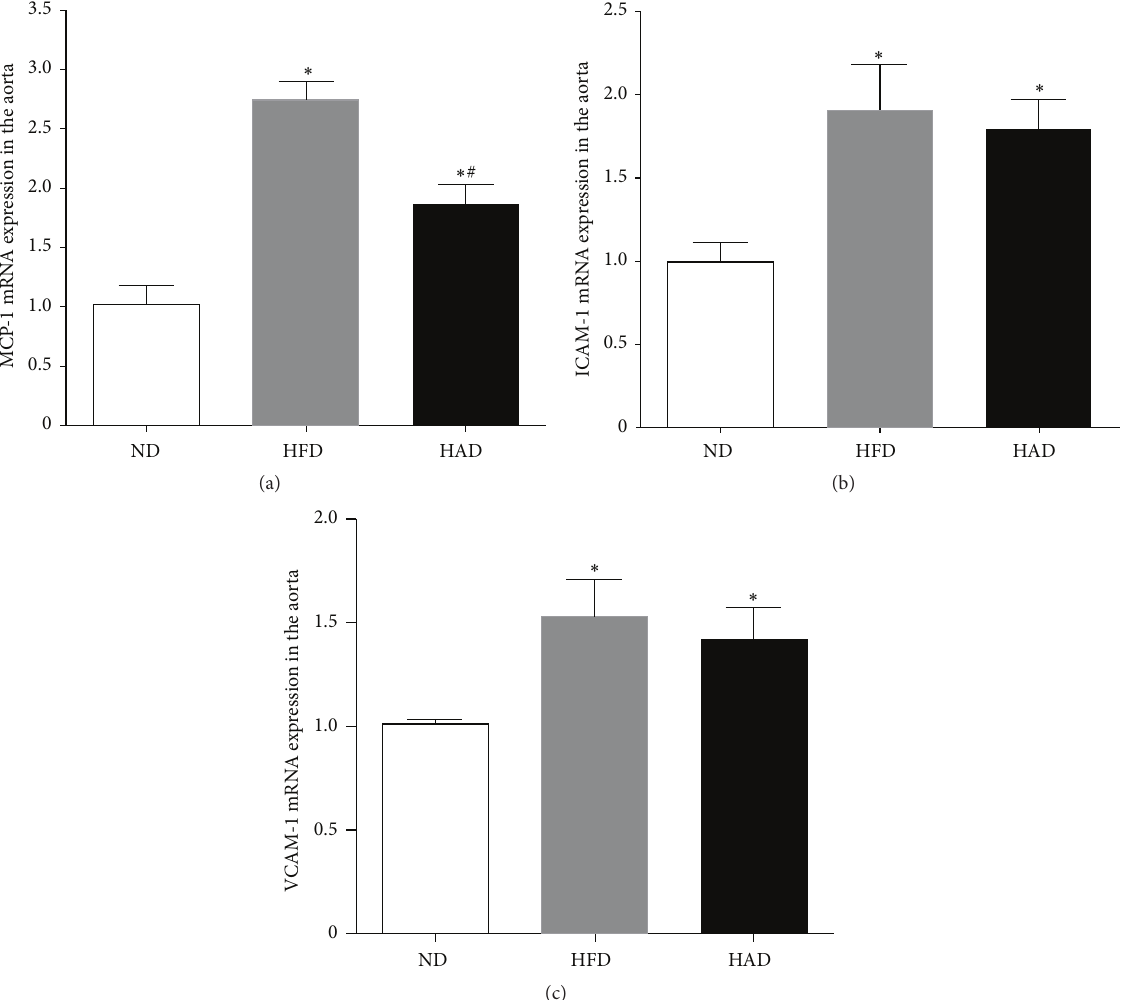
Figure 4: Gene expression in aorta of rats. Gene expression was measured by real-time PCR in each group. (a) MCP-1 mRNA, (b) ICAM-1 mRNA, and (c) VCAM-1 mRNA (𝑛 = 8 – 10) . ∗ 𝑃 < 0.05 , compared with the ND group; # 𝑃 < 0.05 , compared with the HFD